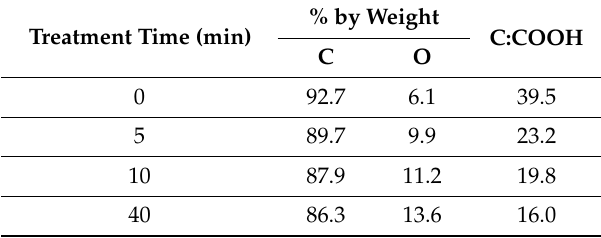
Table 1. Analysis of carboxylated carbon nanotubes (f-CNTs) with different levels of functionalization. Treatment Time (min)